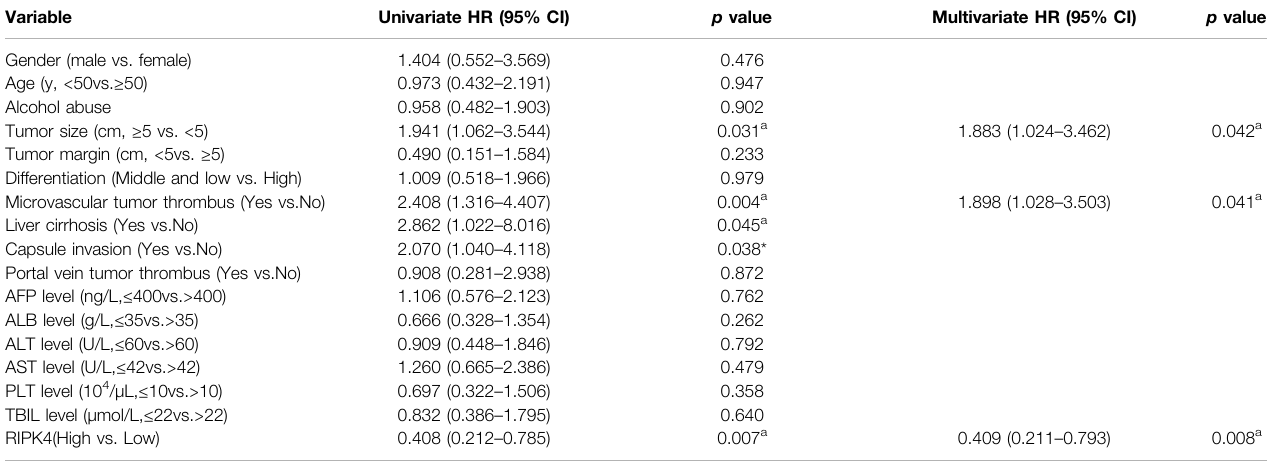
TABLE 3 | Univariate and Multivariate analysis of variables with disease-free survival. Variable Univariate HR (95% CI) p value Multivariate HR (95% CI) Gender (male vs. female)